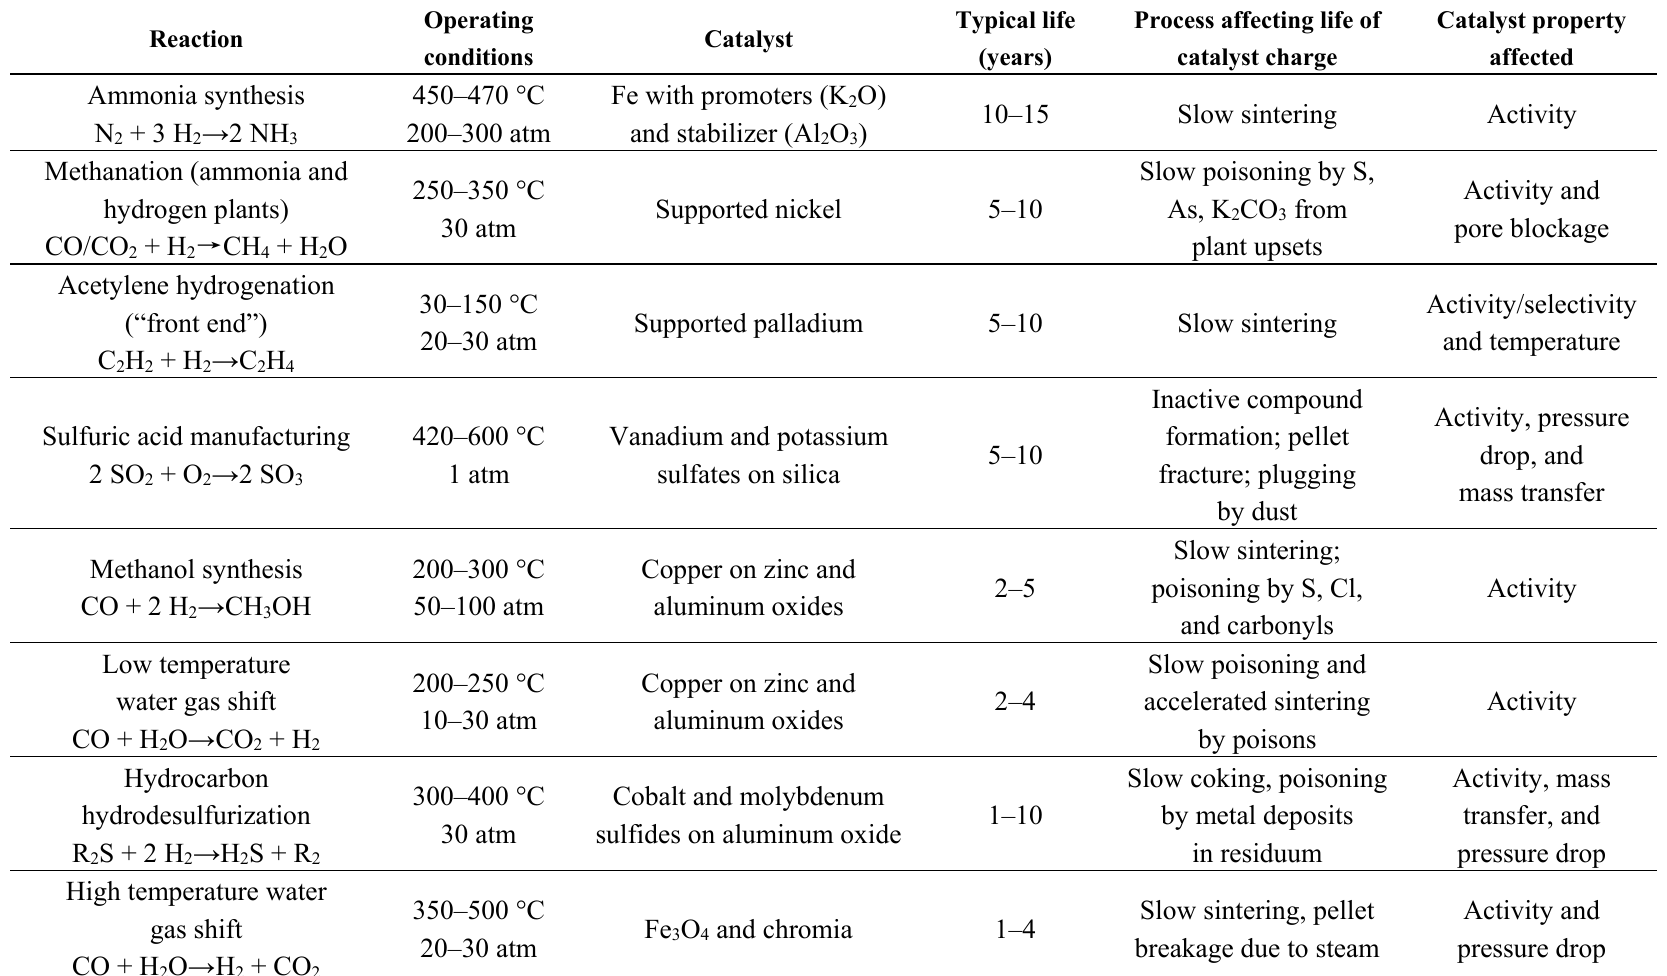
Table 17. Typical Lifetimes and Factors Determining the Life of Some Important Industrial Catalysts a